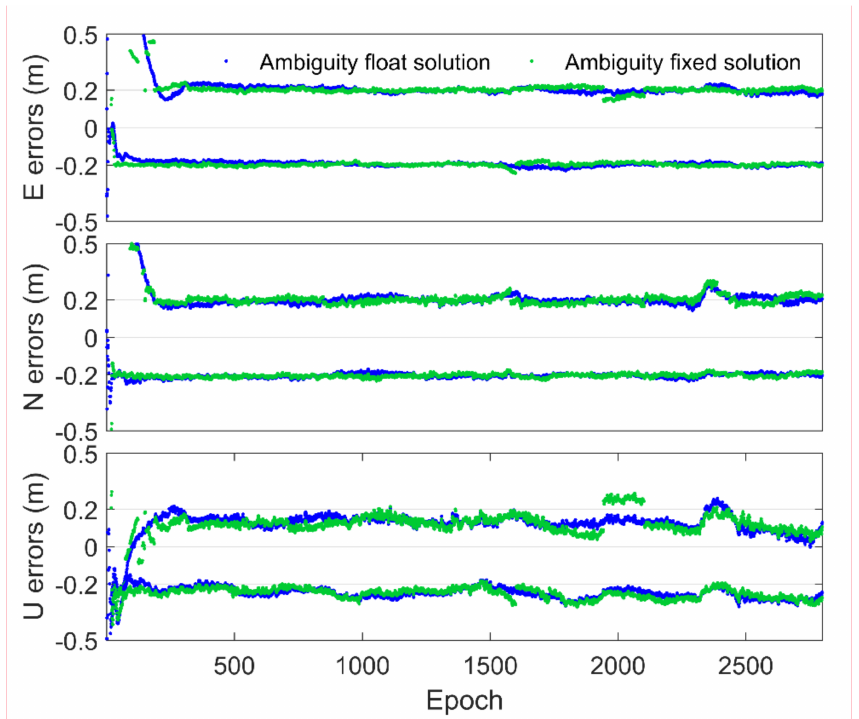
Figure 4. Time series of the ambiguity float and fixed solutions of station HOOG in the case of GPS alone and GPS + Galileo. The solutions of G and GE are shifted by + 0.2 m and − 0.2 m, respectively.